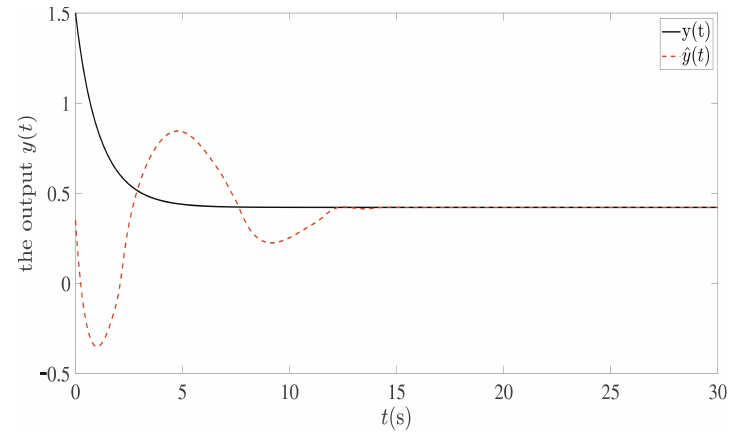
Figure 9. The output and estimated output curves.